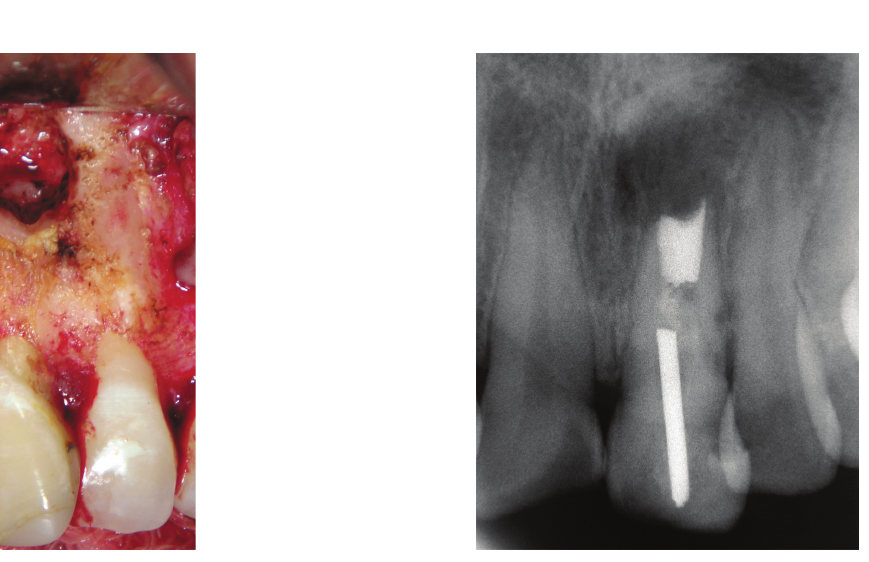
Figure 2: (a) The clinical appearance of the metal fragment located in the periapical tissues. (b) An image showing the length (approximately 10mm) of the metal foreign body that was removed during the surgical procedure.